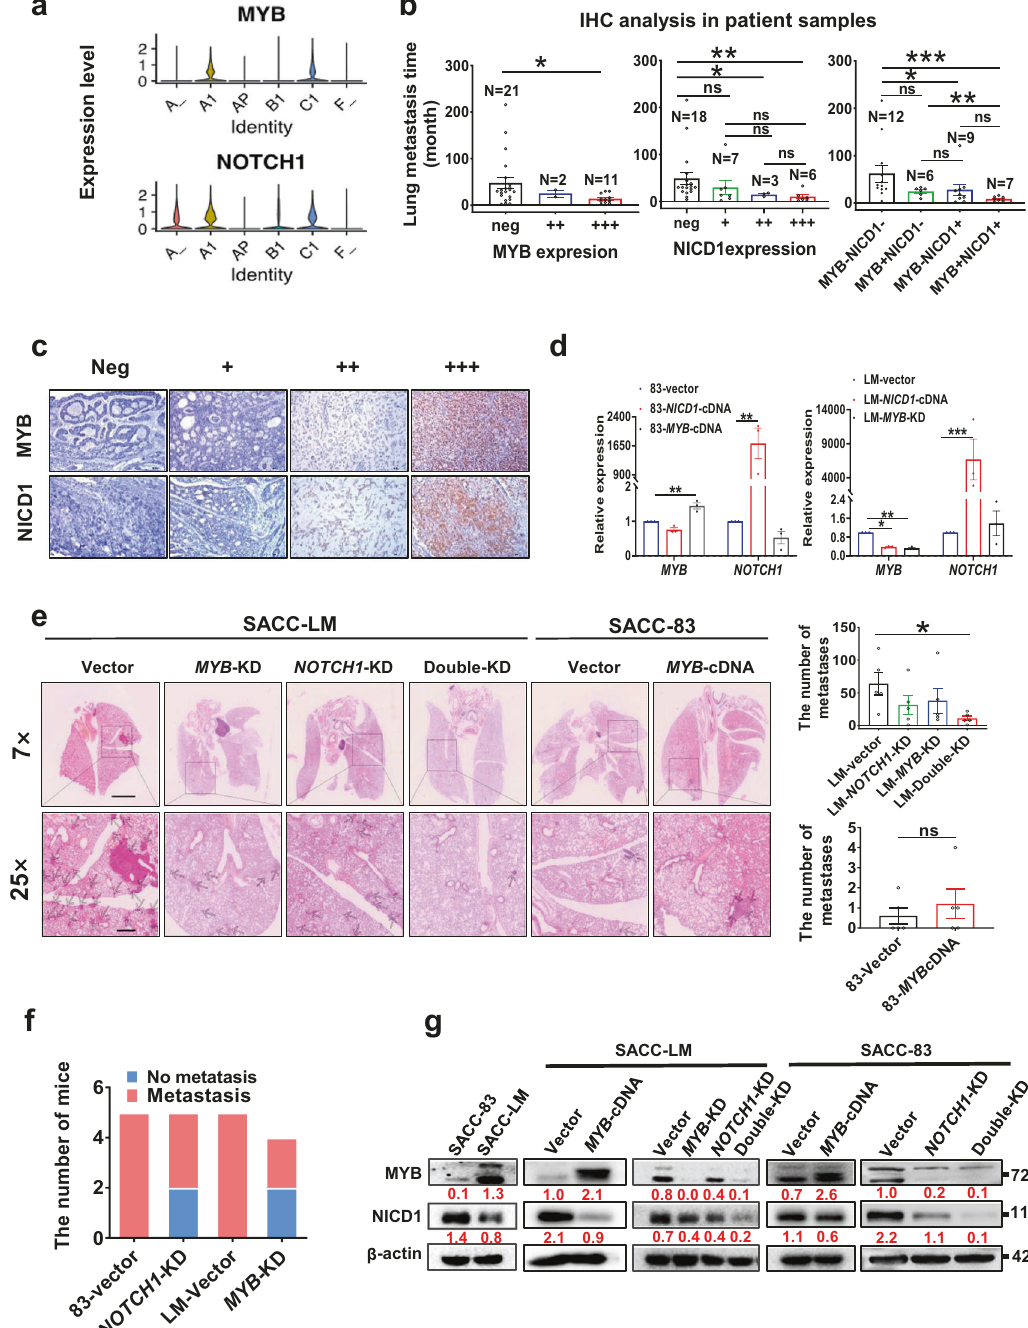
Fig. 3 Abnormal expression of both NOTCH1 and MYB cooperatively promotes the lung metastasis of SACC. a Violin plot depicting the expression levels of MYB and NOTCH1 in six samples. b Statistical analysis of the association between the time to lung metastasis in 34 patients and MYB or/and NICD1 protein levels based on IHC staining. c Representative IHC images of MYB and NOTCH1 expression in lung metastatic lesions from patients ( n = 34). d qPCR analysis of the ef fi ciency of NOTCH1 or MYB overexpression or MYB knockdown in two SACC cell lines. e Representative HE images of lung tissues from mice with metastases at 2 or 4 weeks after tail vein injection with different cell lines (7× and 25× magni fi cation). The statistical analysis of the number of metastases in lung tissues is shown on the right. f Statistical analysis and stacked bar chart of the number of mice with lung metastases at 4 weeks after the left ventricular injection of SACC cells (5 per group). g Western blot validation of MYB and NICD1 expression in SACC-83-vector, SACC-LM-vector, SACC-LM- MYB -cDNA, SACC-LM- NOTCH1 -KD, SACC-LM- MYB -KD, SACC-LM-double-KD, SACC-83-vector, SACC-83- MYB -cDNA, SACC-83- NOTCH1 -KD, and SACC-83-double-KD cells. β -Actin served as a loading control ( n = 3). The p values in ( b ) and ( e ) were calculated using the two-tailed Mann – Whitney U- test, and those in ( c ) were calculated using the paired two-tailed Student ’ s t -test. Data were presented as the mean ± SEM. p < 0.05 (*), p < 0.01 (**), p < 0.001 (***), and p > 0.05